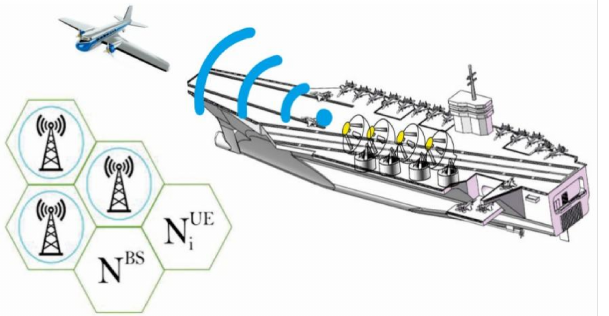
Figure 1. Spectrum-sharing description for massive MIMO radar and target point at the same time splitting spectrum with massive MIMO mobile cellular